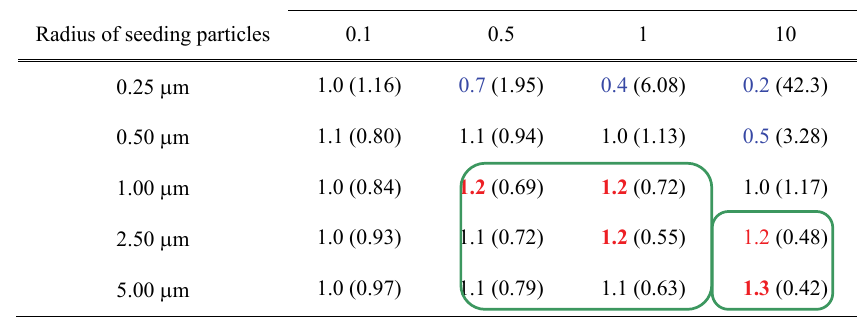
Table 3. Ratios of seeded-case to non-seeded-case accumulated surface rainfall averaged over the domain at 160 min. Seeding of stratiform cloud is carried out with monodisperse salt particles of different sizes and total masses. Ratios in blue and red indicate a significant decrease and increase, respectively. Ratios of seeded-case to non-seeded case (180 cm -3 ) cloud droplet number concentrations at 100 m above the base of the cloud center at 62 min are shown in parentheses.